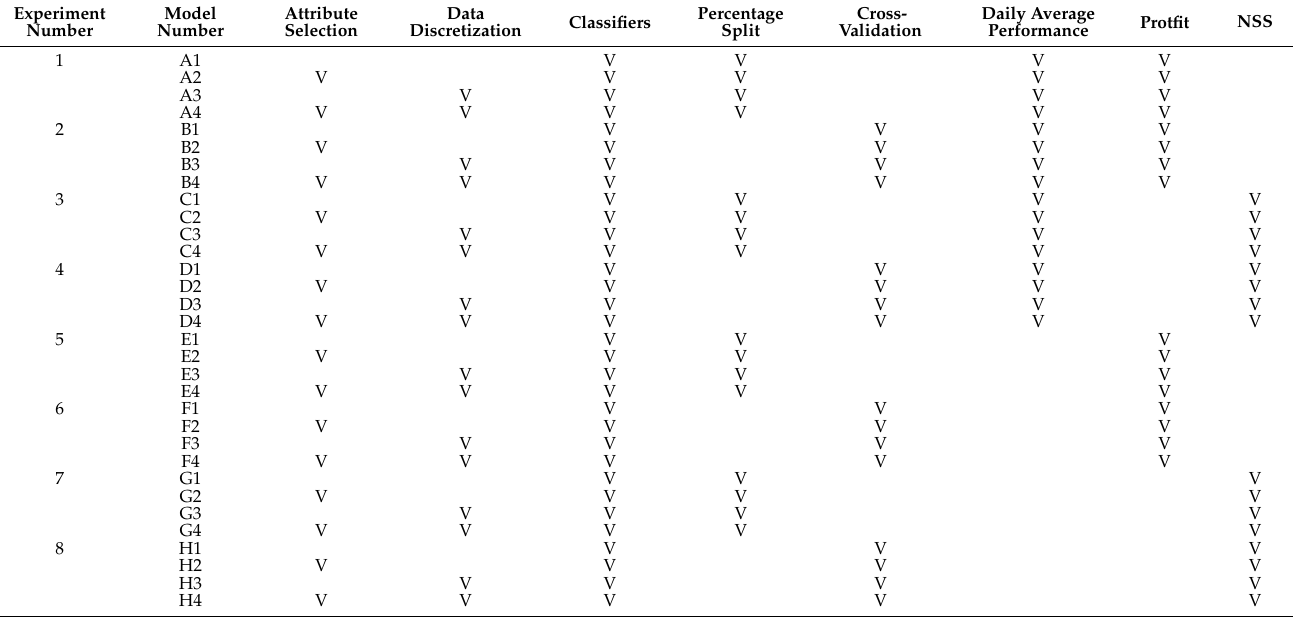
Table 5. Eight experimental